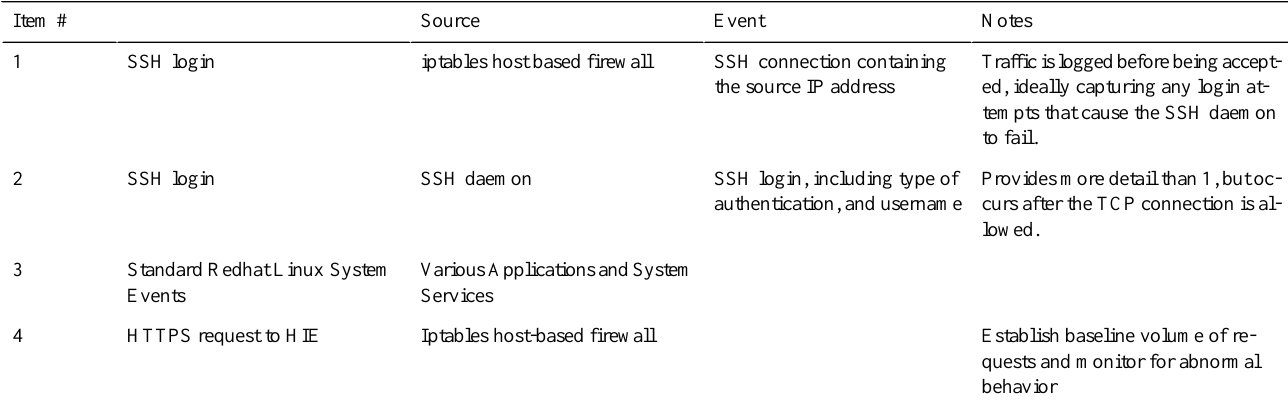
Table 3. Audited events from servers. NotesEventSourceItem